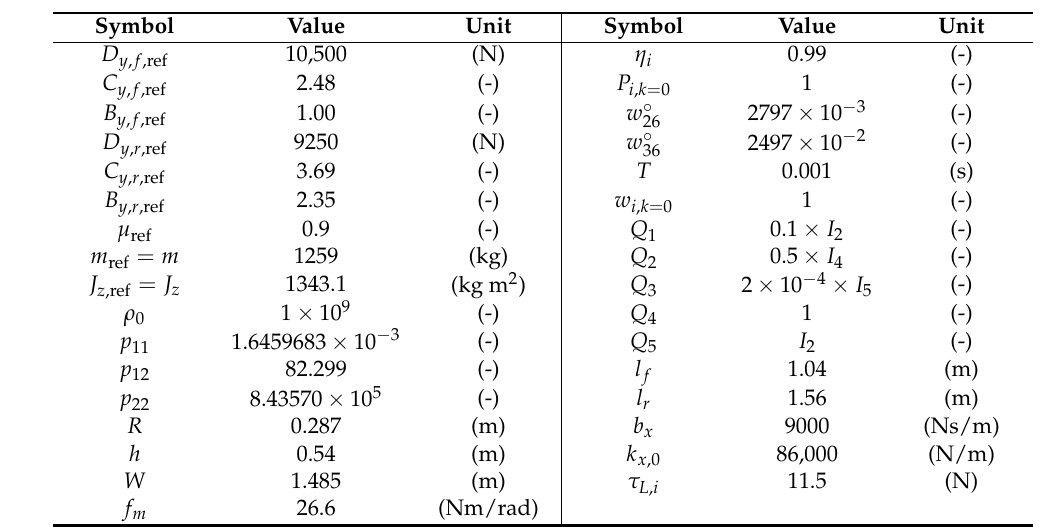
Table 2. Parameters used in the control scheme.